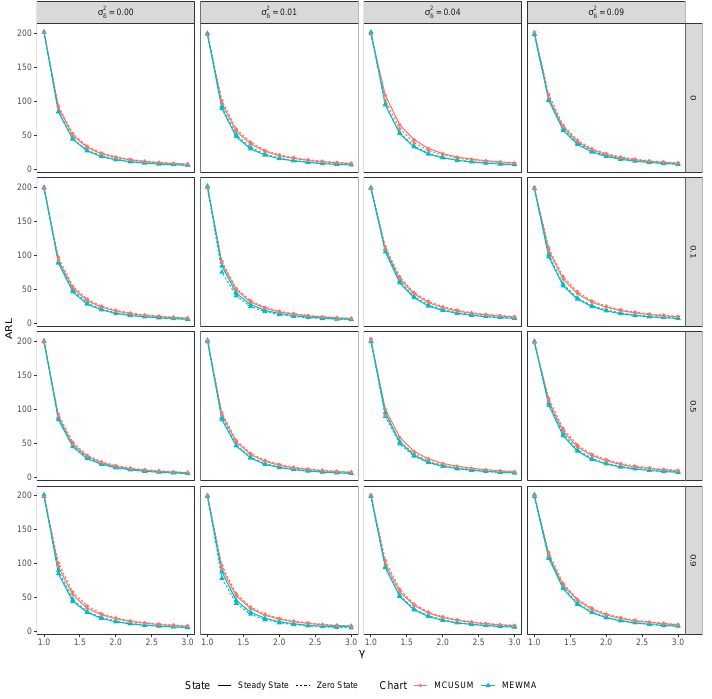
Figure 3. Zero-state and steady-state ARL for MCUSUM and MEWMA under shift in standard deviation. Effect of Ignoring Measurement Error and/or Random